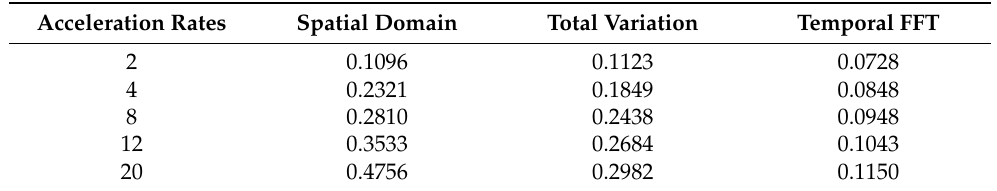
Table 4. Performance comparison of different sparsity transforms using mean squared error in the transform domain. Temporal FFT performs better in cardiac cine MRI.